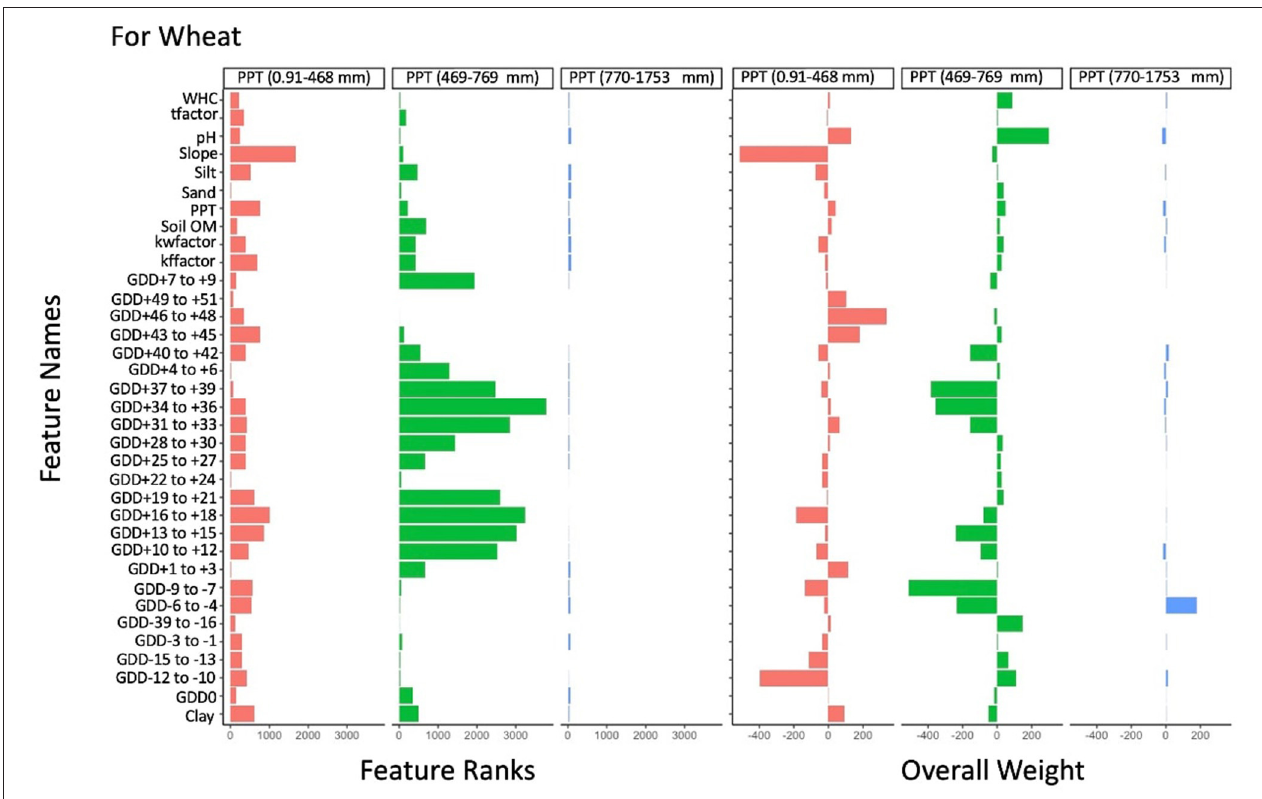
FIGURE 9 | Feature ranks and overall weight of features following explainable machine learning interpretations for wheat for low, medium, and high quartiles of precipitation.